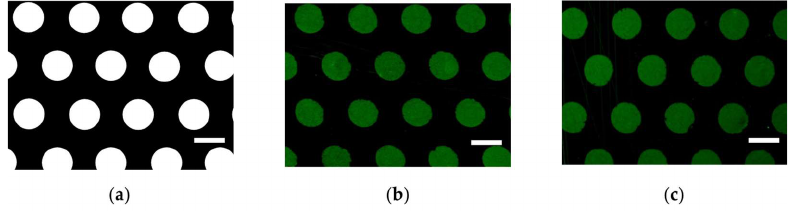
Figure 4. ( a ) Phase-contrast image of photomask. ( b ) Micropatterning test of AzPEG 350 [10] and ( c ) micropatterning test of AzPEG 750 [5] performed using photomask. The micropattern plate had two different regions, as indicated by the green and dark sections. In the photomask, the green section allowed UV light to enter the AzPEGx [y]–Alexa488IgG complex, resulting in photoimmobilization, which was not possible in the dark sections. Scale bars: 500 µm.